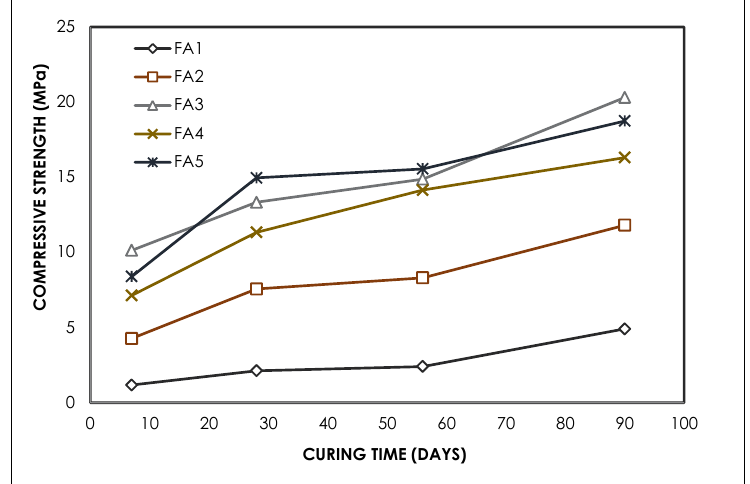
Figure 4: Twelve hours compressive strength of cured bricks